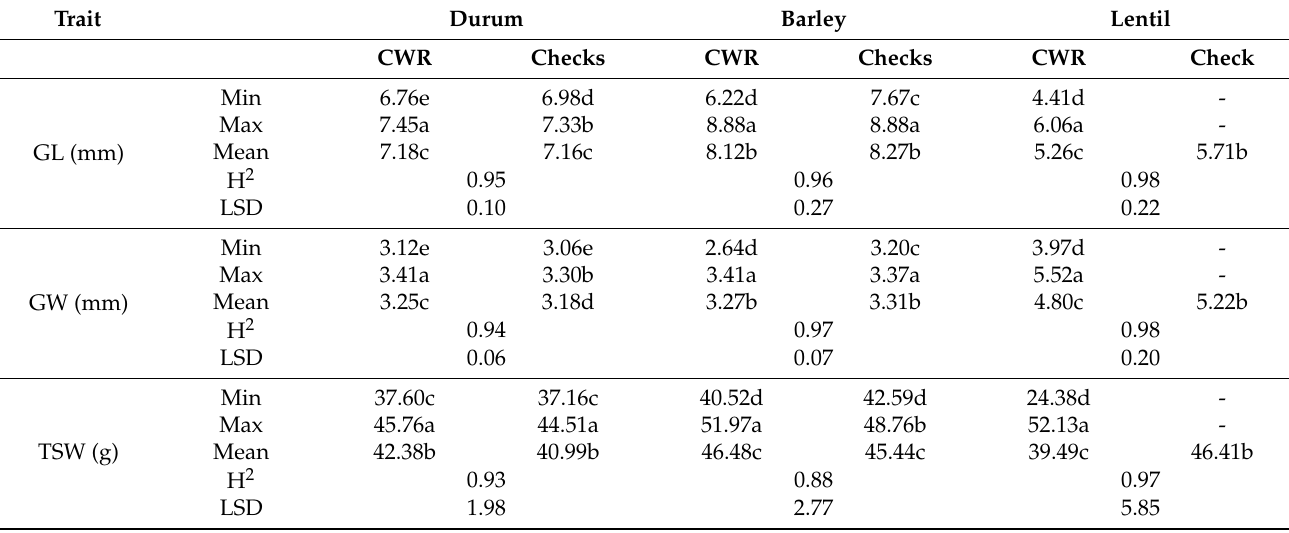
Means for each variable followed by the same letters are not significantly different ( p < 0.05). GL; grain length, GW; grain width, TSW; 1000-seeds weight.